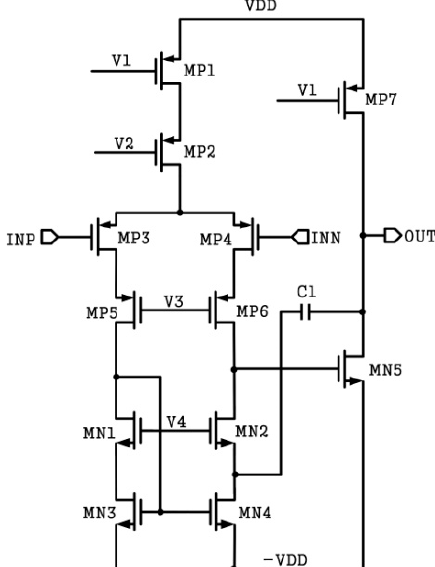
Figure 5. OTA schematic of analog front-end.